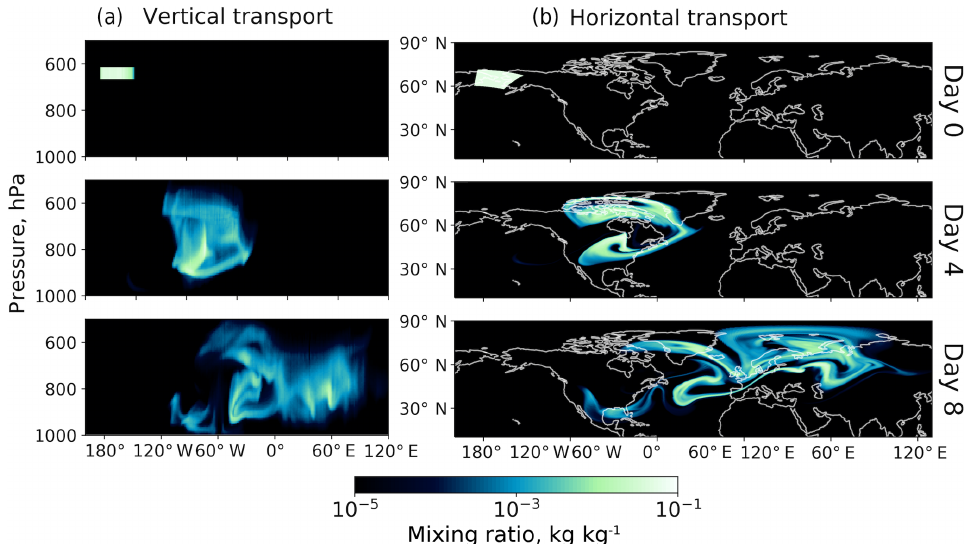
Figure 3. The 8-day simulation of plume transport in the FV3 dynamical core at C384L160 resolution ( ≈ 25km in horizontal and 6hPa in vertical). The plume is initialized at 625hPa over Alaska with a normalized mixing ratio of unity over a domain 1000 × 1000km 2 in the horizontal and 50hPa thickness in the vertical. Panel (a) shows the vertical and longitudinal transport of the plume as the meridionally averaged mixing ratio. Panel (b) shows the horizontal transport of the plume as column-averaged mixing ratios. Because mixing ratios are plotted here as meridional or vertical averages, the values are much lower than the actual values in the